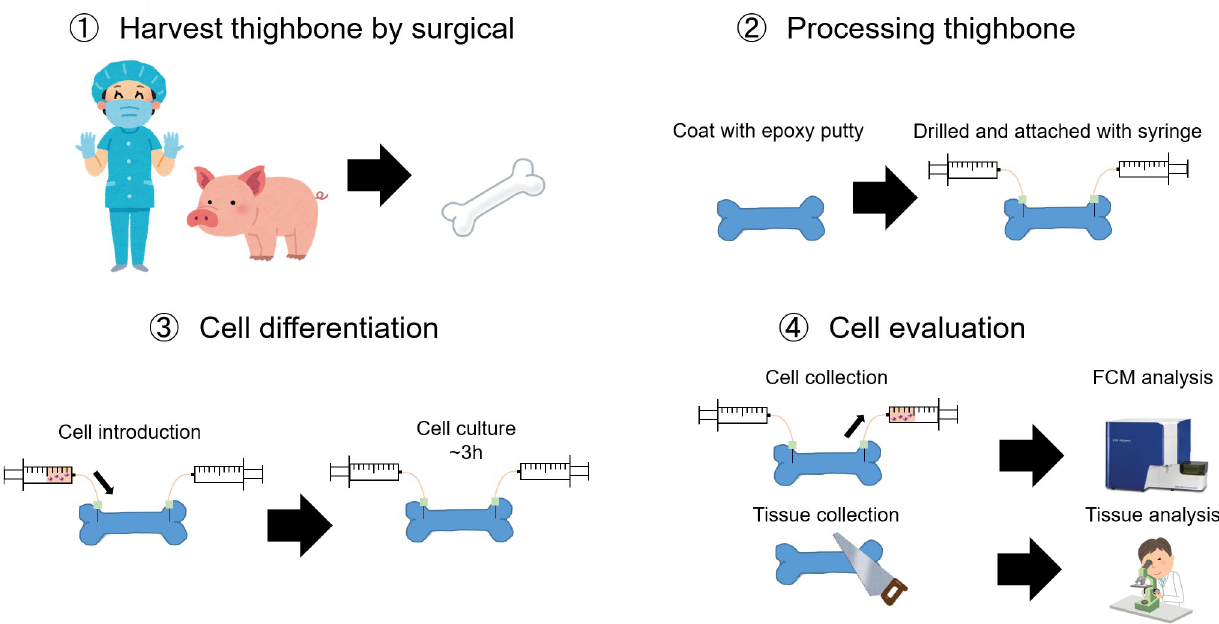
Fig 2. The ex vivo production system procedure. (1) Porcine thighbone was surgically harvested. (2) The thighbone was coated with epoxy putty, drilled and attached with syringe. (3) Megakaryocytes were introduced into the thighbone by perfusion and then cultured for 3hours. (4) The produced platelet- like cells were collected by perfusion and then analyzed by flow cytometry. Alternatively, the bone marrow was frozen and later analyzed by tissue immunohistochemical staining.